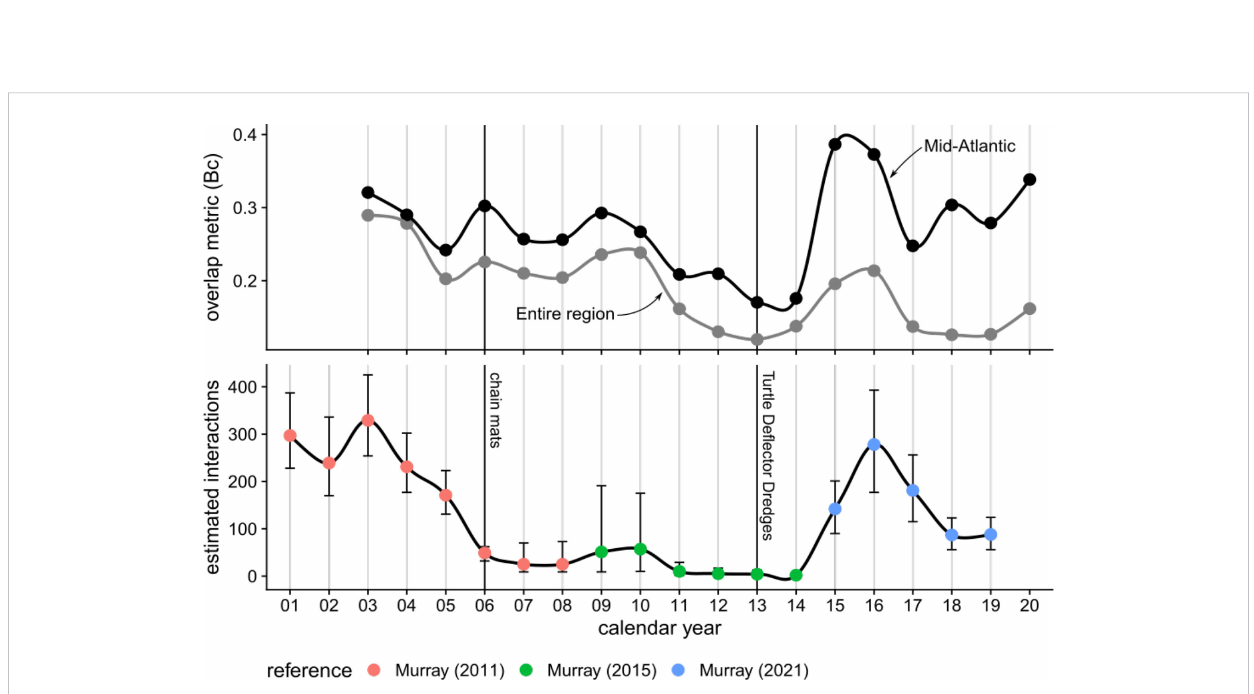
FIGURE 5 Time series of overlap values averaged across months by calendar year, with grey = entire region and black = Mid-Atlantic region as de fi ned by Murray (2011); Murray (2015); Murray (2021), and published annual interaction estimates for loggerhead turtles in the U.S. Atlantic sea scallop dredge fi shery. Years when gear modi fi cations were implemented are noted, with chain mats being implemented since September 2006 and Turtle De fl ector Dredges being implemented since May 2013. Both gear modi fi cations are required when fi shing for sea scallops between May and November in U.S. waters west of